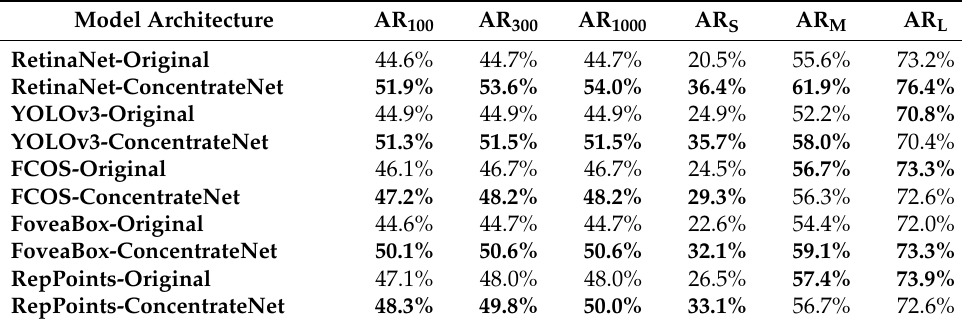
Table 7. Object detection recall evaluation